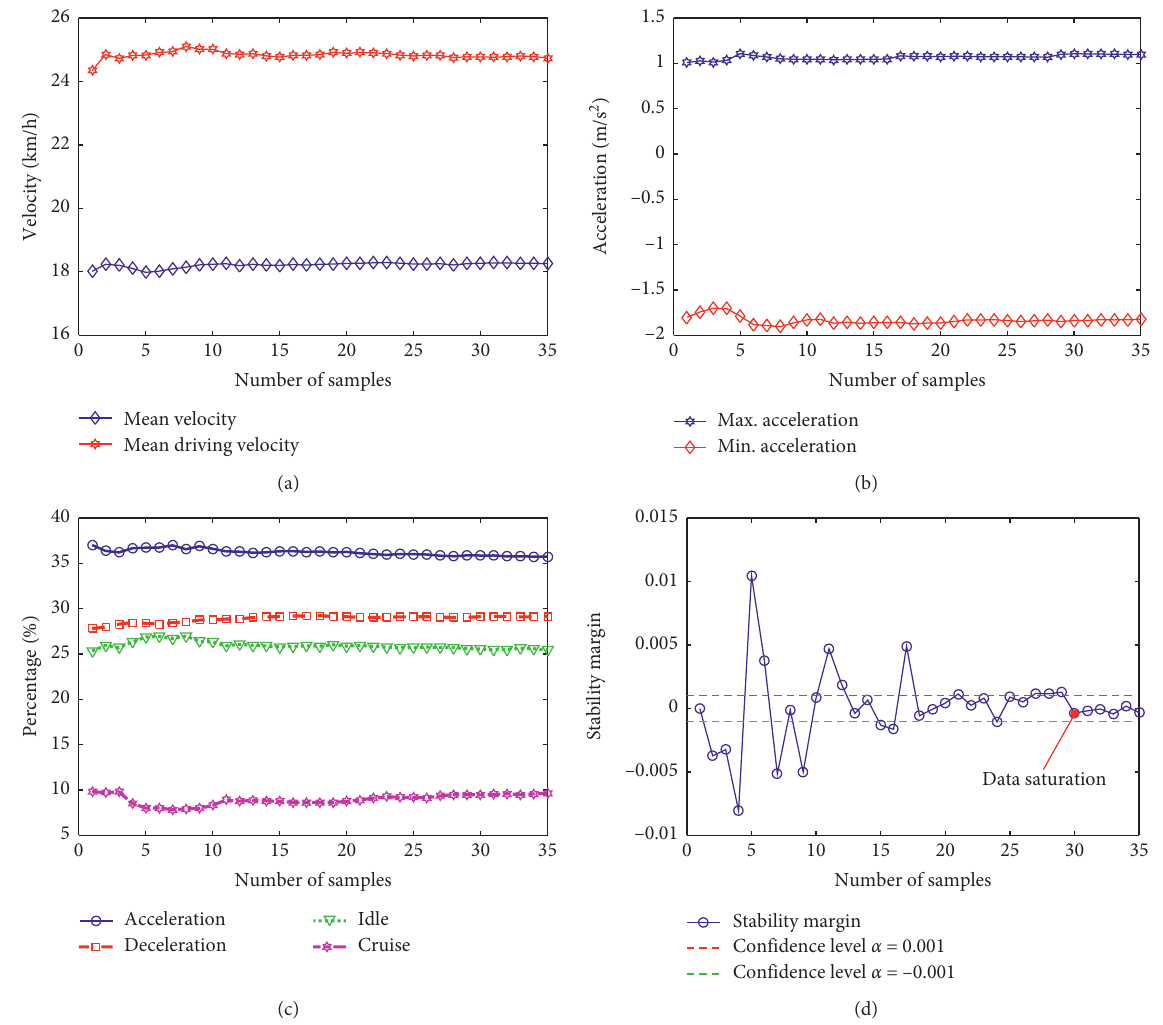
Figure 2: Saturation analysis of driving data sampling. Variation of (a) v increase in samples.